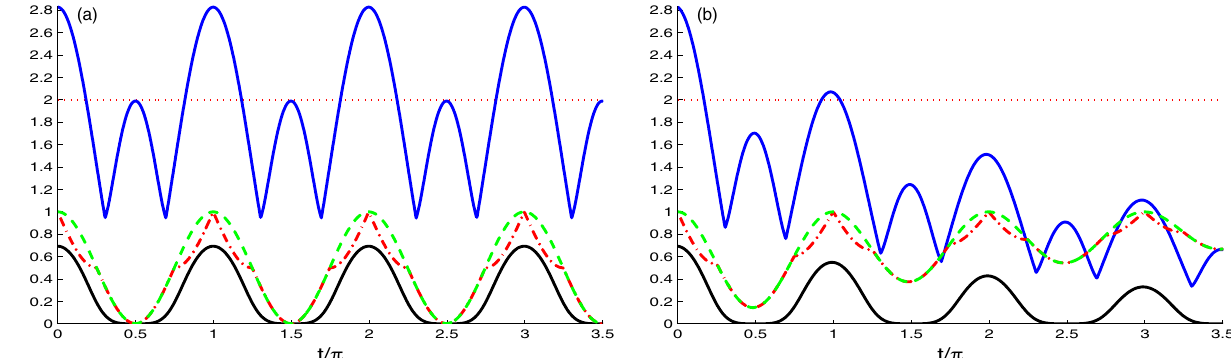
Figure 4. Time evolution of L ( t ) (dashed plots), U ( t ) (dashed dotted plots), M ( t ) (upper solid plots) and N ( t ) (solid plots) for large coupling case J